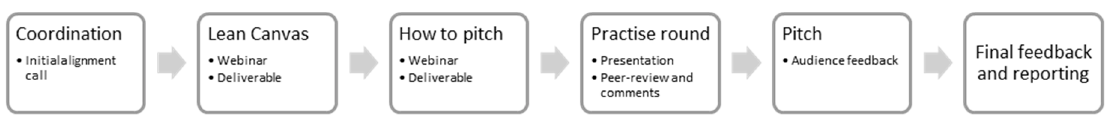
Figure 1. Steps towards the Pitching